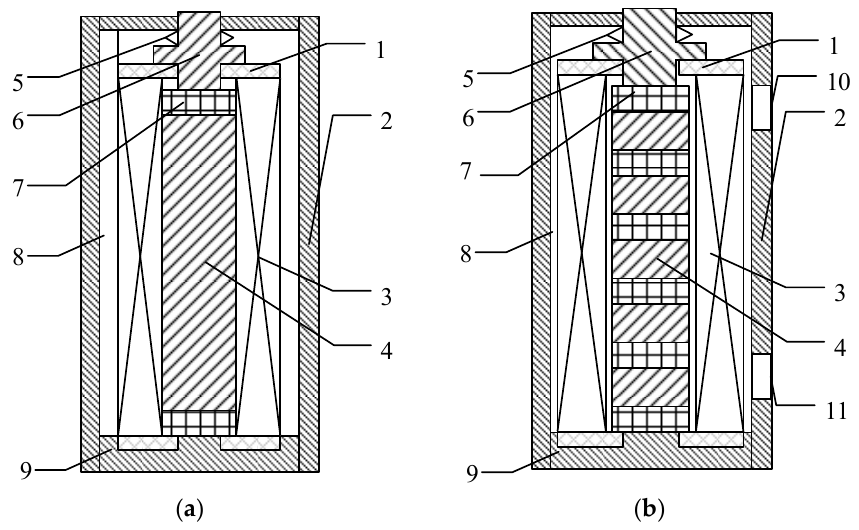
Figure 1. Giant magnetostrictive actuator (GMA): ( a ) Non-stacked, ( b ) stacked. 1. Coil skeleton; 2. Shell; 3. Coil; 4. Giant magnetostrictive material (GMM) rod; 5. Preloaded disc spring; 6. Ejector; 7. Permanent magnet; 8. Oil cavity; 9 End cap; 10. Cooling oil inlet; 11. Cooling oil outlet. Because the structure of the GMA is axisymmetrical, its internal magnetic circuit is also symmetrical.